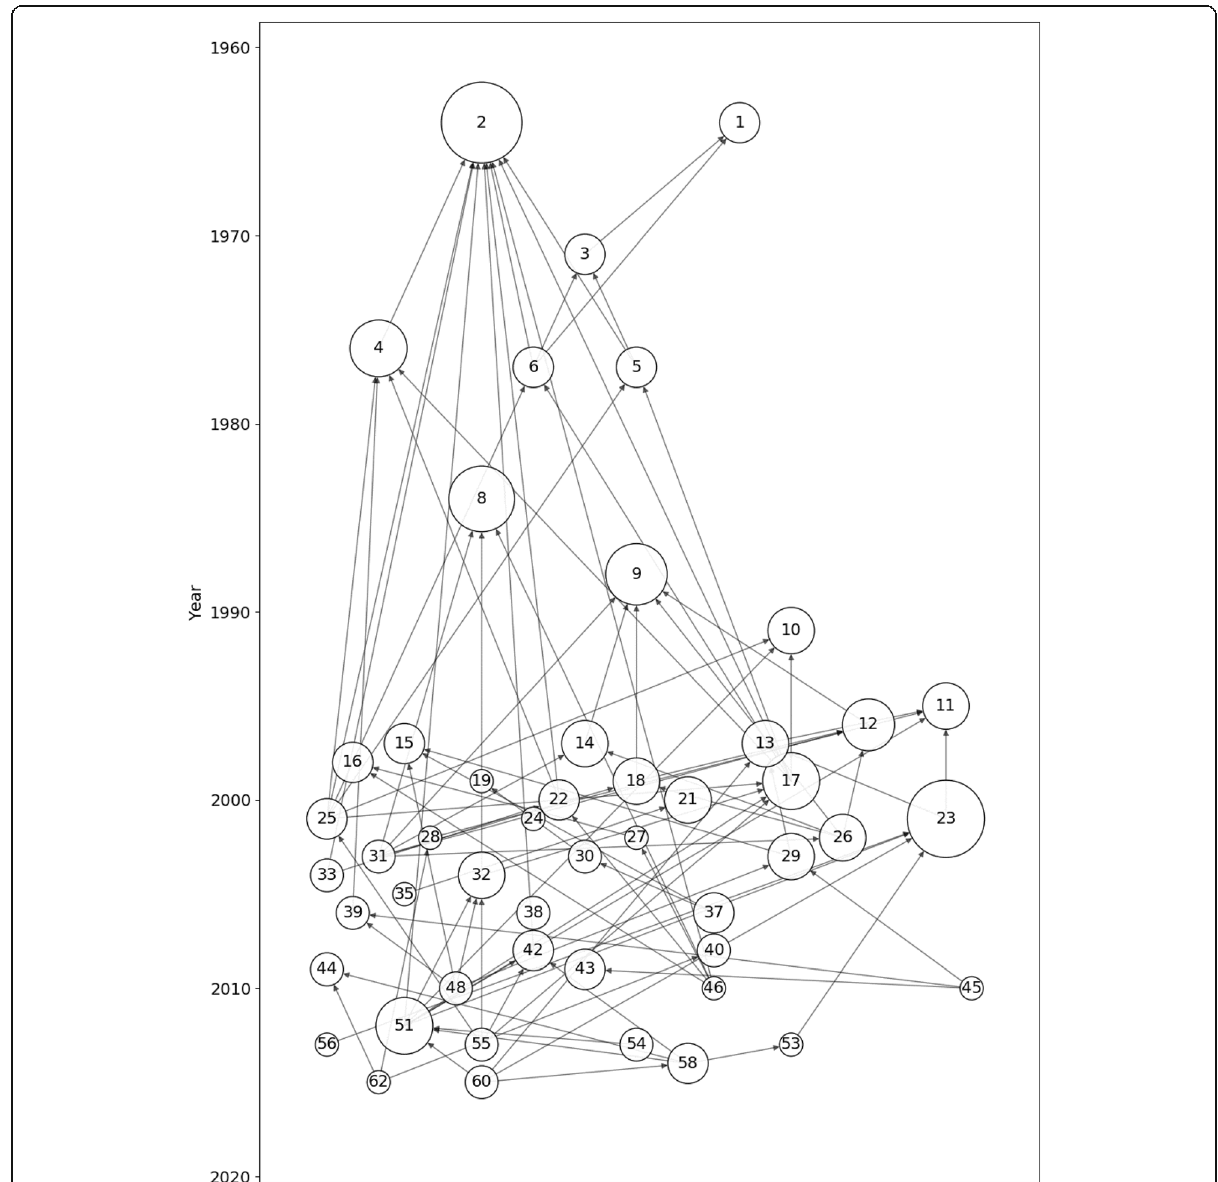
Fig. 4 Citation network for the literature reviewed in this paper and defined in Table